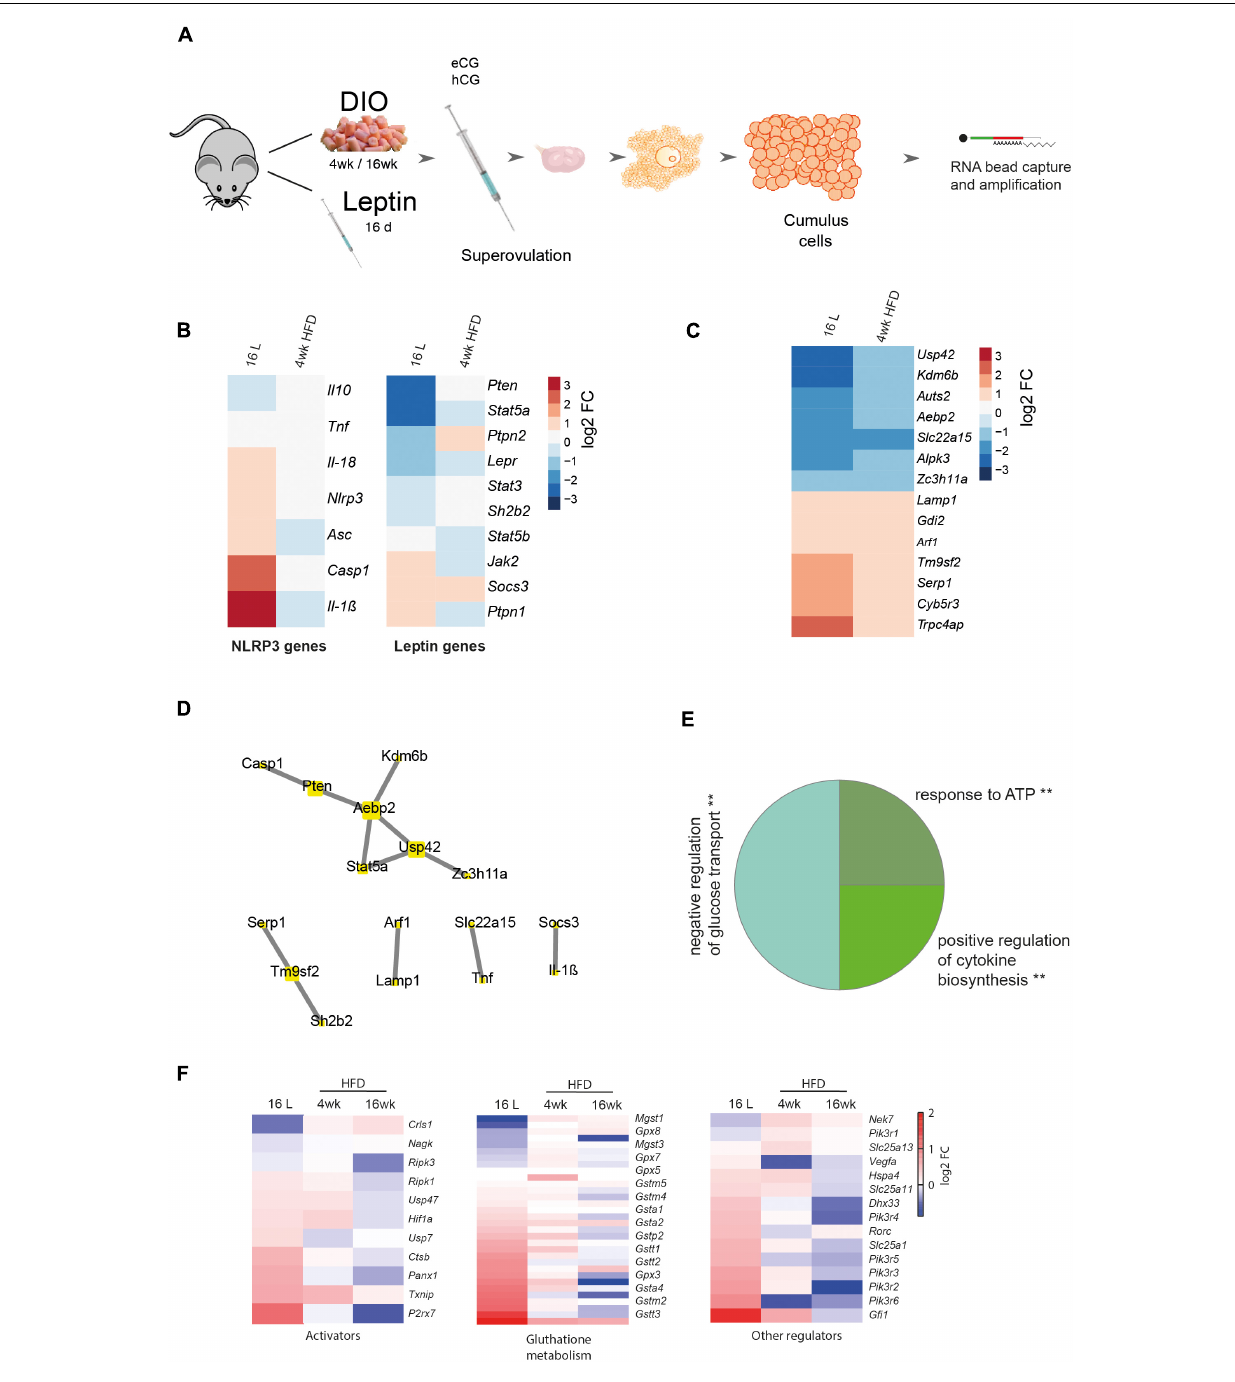
Frontiers in Cell and Developmental Biology |